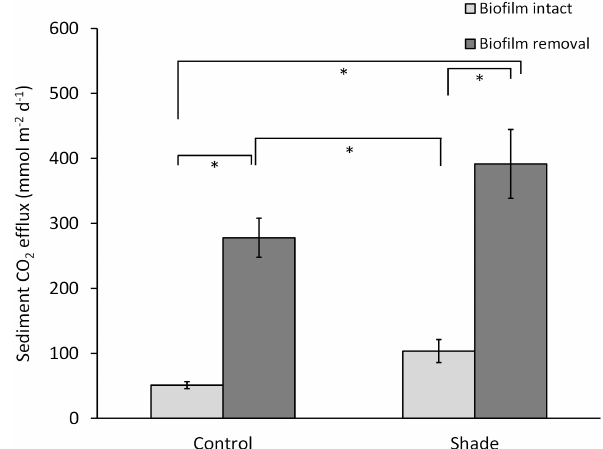
Figure 2. Mean sediment ( ± SE) CO 2 efflux (mmolm − 2 d − 1 ) before and after surface biofilm removal, from control ( n = 6), and pre-shaded sediment ( n = 6) at intact mangrove site Hatea 1. ∗ Significant difference ( p <0.01).